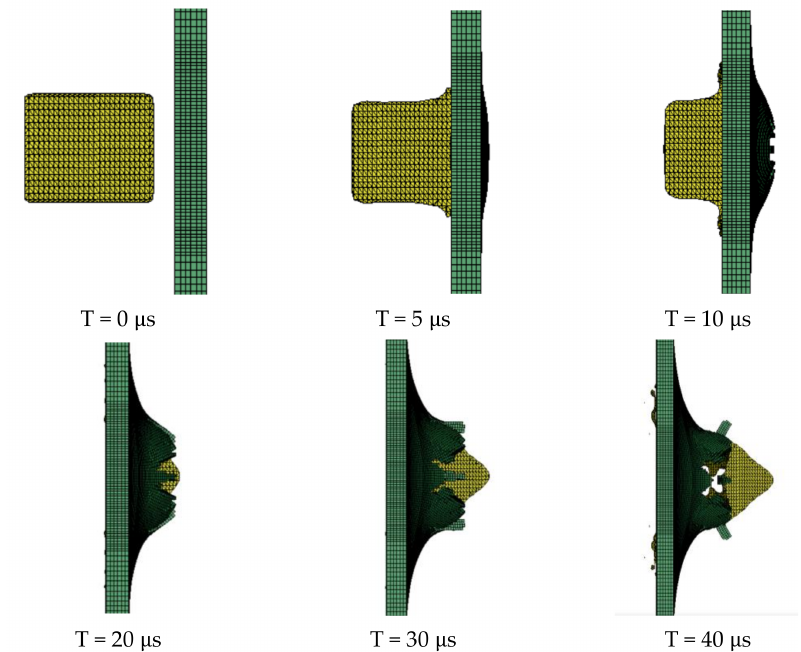
Figure 5. The process of projectile-target